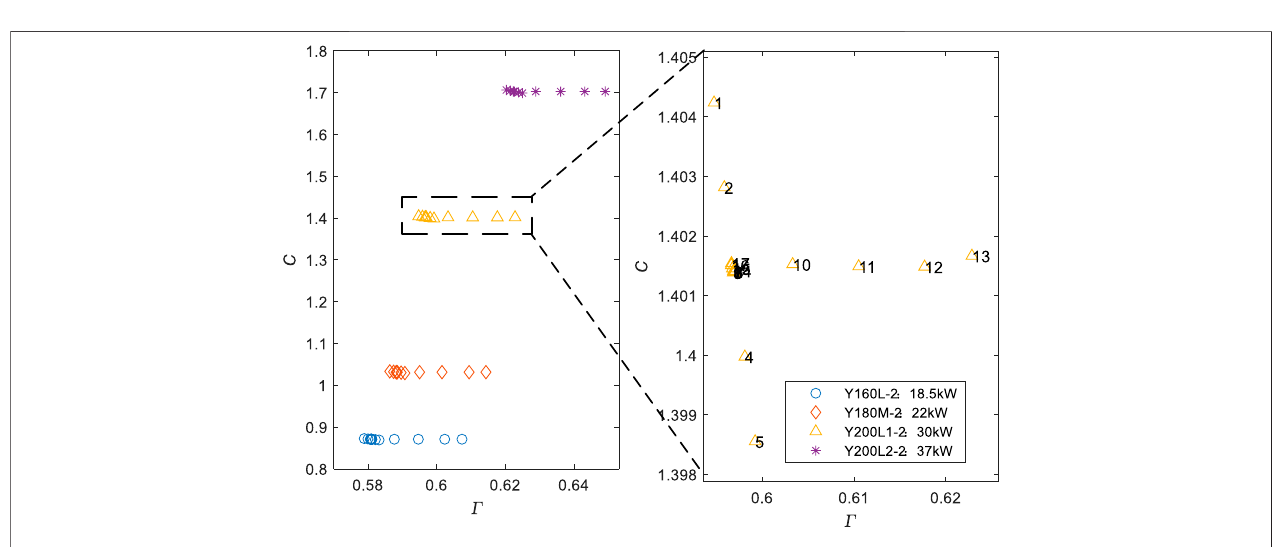
FIGURE 6 | Distribution of feature parameters of motors with the same number of poles but different rated